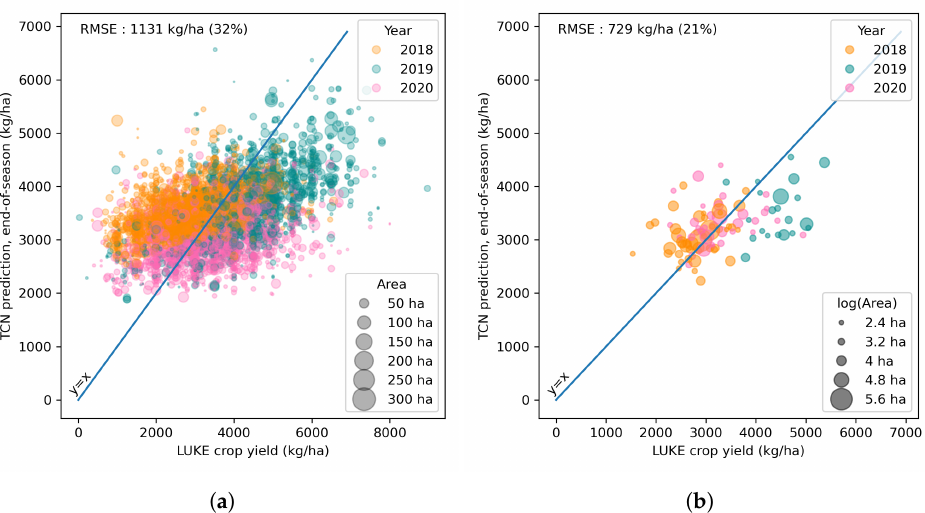
Figure 12. Scatter plots of farm- and region-level predictions vs. actual, when using histogram-based features with temporal convolutional network model, spring wheat, in 2018–2020, from cloud-masked data. The root-mean-squared error (RMSE) is shown in kg/ha and as a percentage from the average of the actual test set yield. The size of the point is proportional to the area of the observation (farm or region) in hectares. The years are denoted in colors. ( a ) Farm level. ( b ) Region